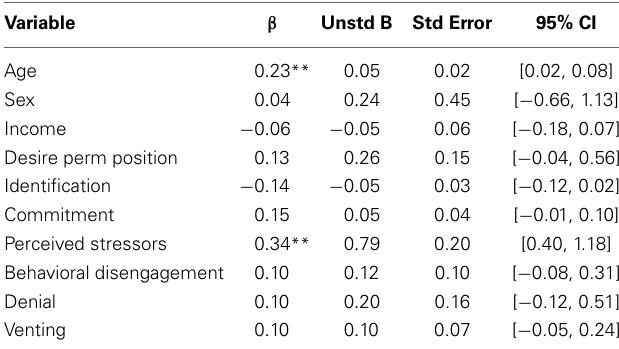
Table 7 | Standard multiple regression analysis predicting perceived harm in the workplace.